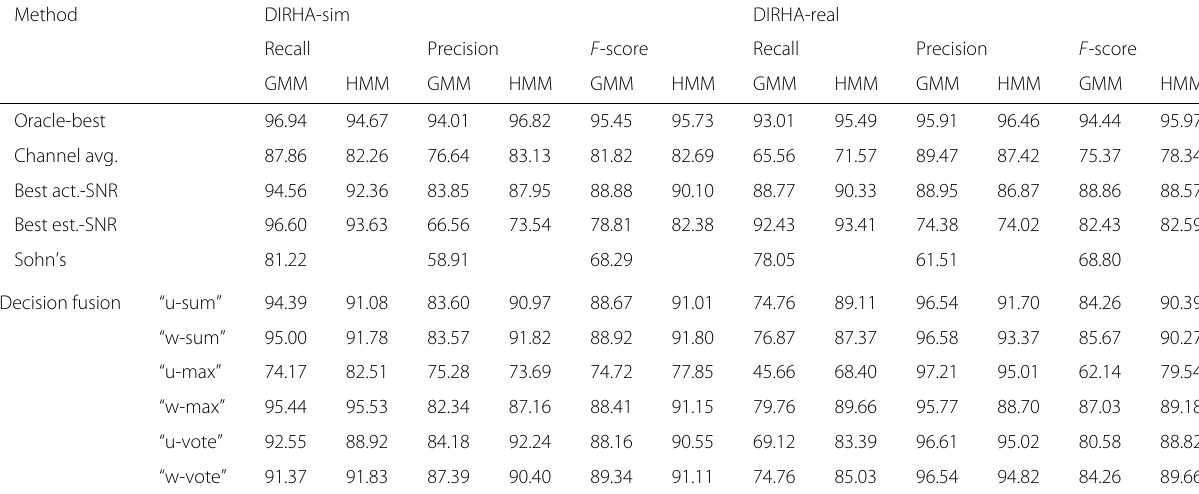
Table 2 Room-independent SAD results on the DIRHA-sim (left) and DIRHA-real (right) test sets, further discussed in Section 8.1 Method DIRHA-sim DIRHA-real Recall Precision F -score Recall